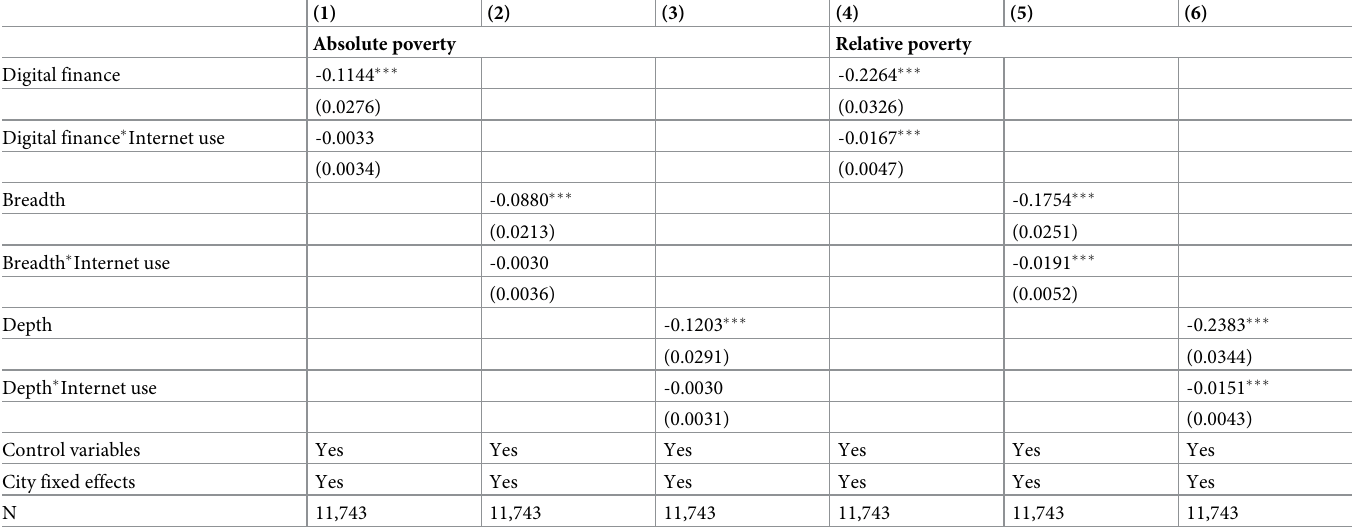
Table 8. Digital finance, Internet use, and rural household poverty.